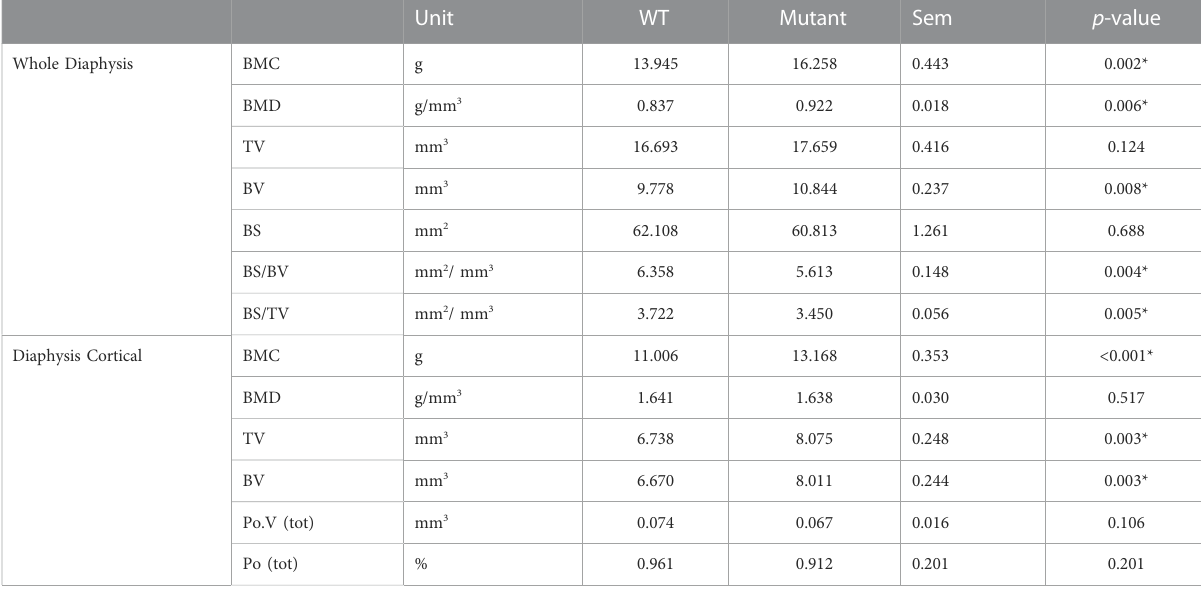
TABLE 2 Diaphyseal properties of WT and MSTN mutant tibia